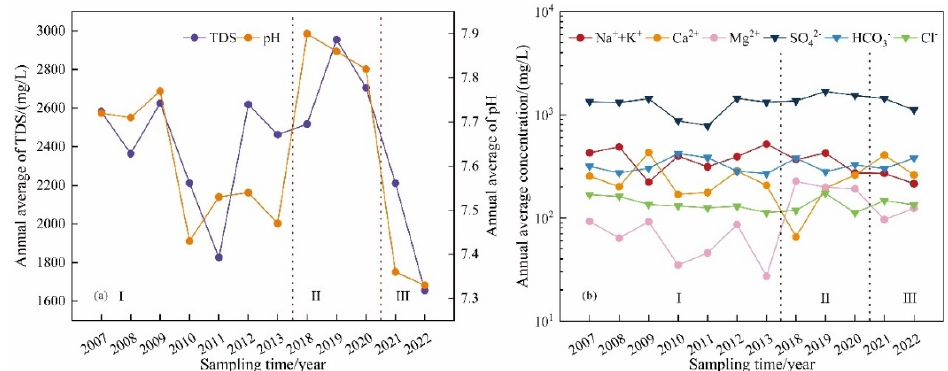
Figure 4. Variation characteristics of chemical indexes of karst groundwater in Taiyuan Formation. ( a ) Evolution of annual average content of TDS and pH, ( b ) Evolution of Annual Average Content of Cations and Anions.